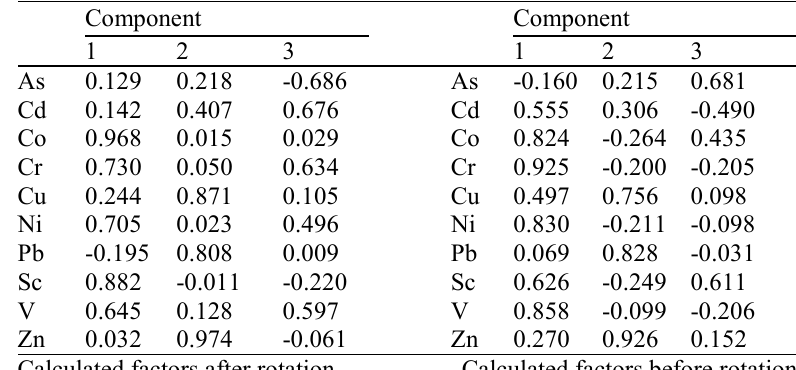
Table 11. Calculated factors before and after rotation